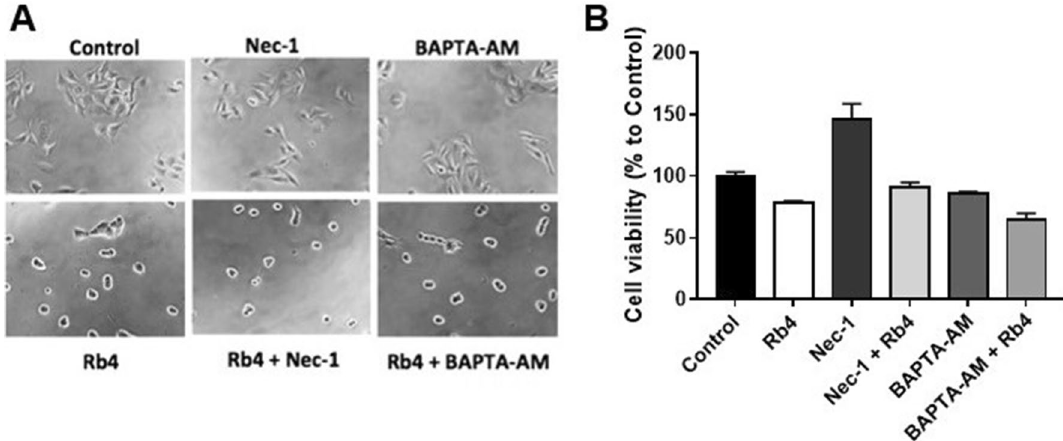
Figure 6. Rb4 peptide effect on the morphology and viability of B16F10-Nex2 cells is independent of the enhanced level of calcium in the cytosol and RIP1 expression. B16F10/Nex2 cells were stimulated with 0.15 mM of Rb4 for 16 h in the presence or absence of 5 µM BAPTA-AM or 100 µM Necrostatin-1 (Nec-1). BAPTA-Am and Nec-1 were added 1 h before Rb4. BAPTA-AM and Nec-1 controls were performed. ( A ) The cell morphologies were determined by interference light microscopy. Images were magnified ×200. ( B ) The cell viability was determined by MTT assay.